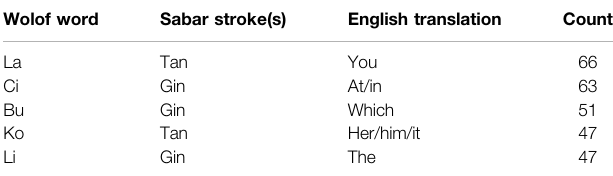
TABLE 3 | The most common word-stroke combinations.